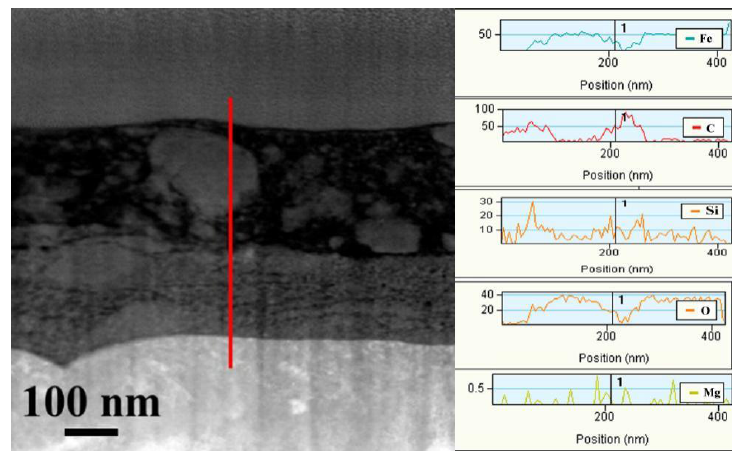
Figure 10. EDS lines distribution of main elements of tribofilm (The color lines in cross-sections corresponding to the direction of EDS lines). Nanomaterials 2020 , 10 , x